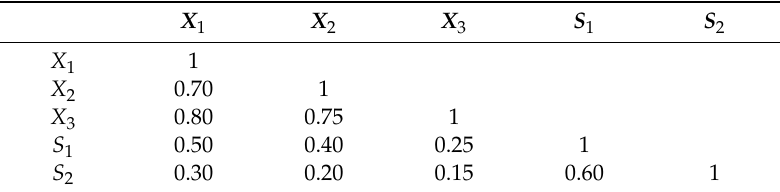
Table 1. Pearson’s correlation matrix of X 1 , X 2 , X 3 , S 1 , S 2